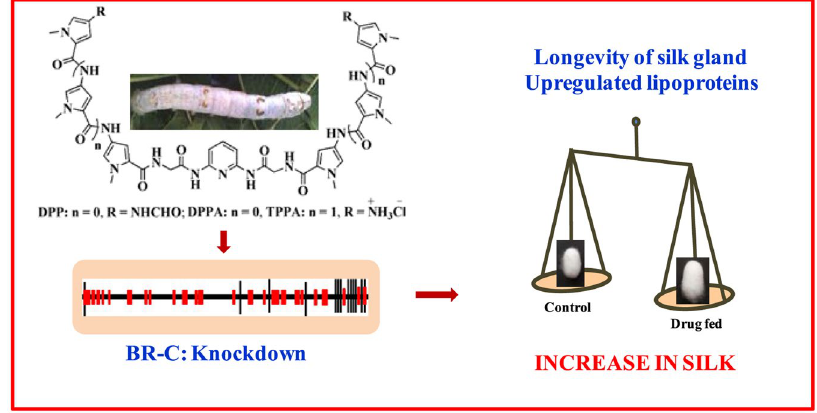
Figure 7. Effect of drugs on knockdown of broad-complex gene leading to enhanced silk production. The figure shown here is a compilation of images. The photographs of worm and cocoon were taken by one of the coauthors, AA. Compound molecular structures and the schematic representation of BR-C gene were drawn by AA. The red boxes indicate 5 ′ -TTAGG-3 ′ repeats. Lines connect the actual order of the exons. The TTAGG repeats are not to scale. The weighing balance was drawn by AM and